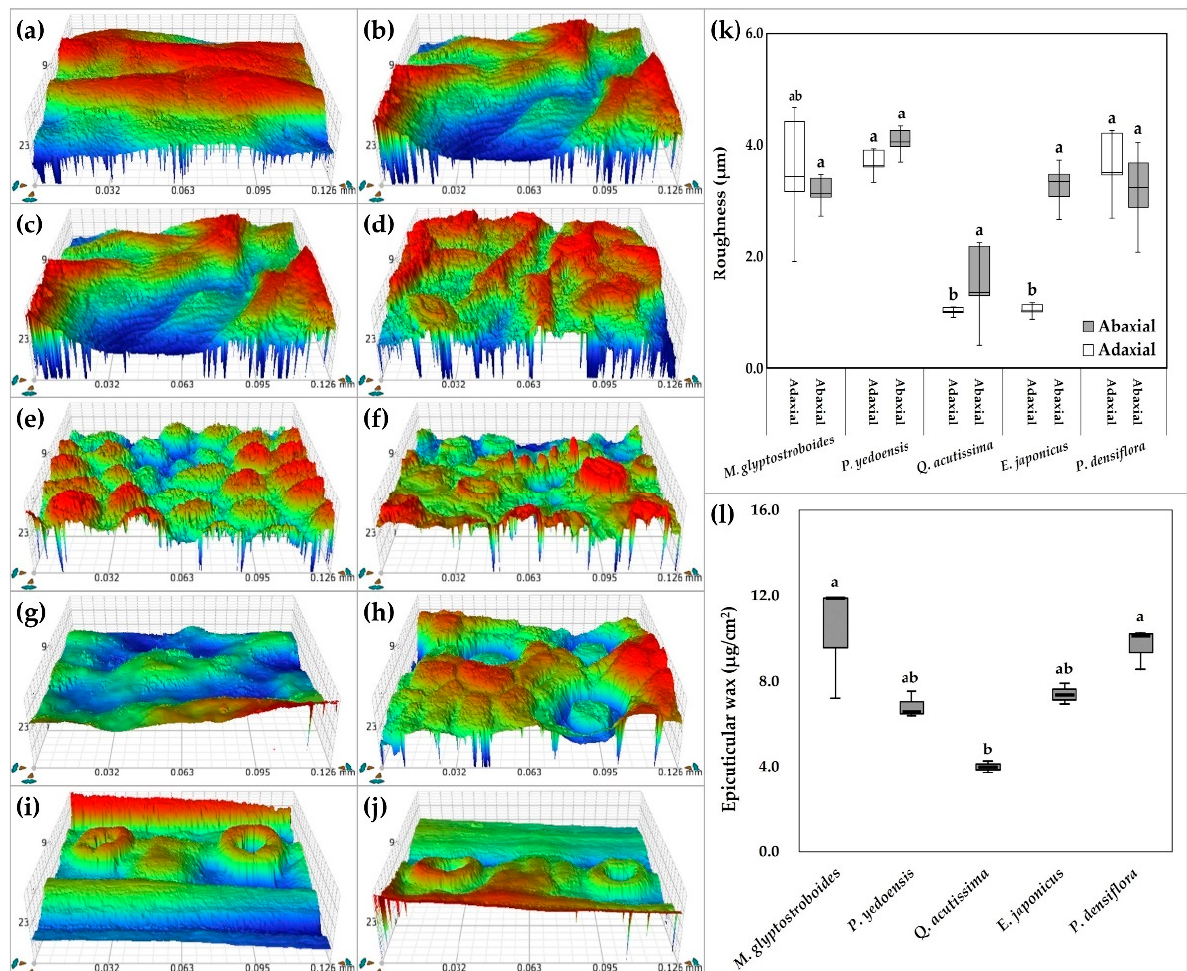
Figure 5. 3D surface topography variations of leaf surfaces among different species, which are distinguished by roughness and epicuticular wax: ( a – j ) 3D surface topography reconstructions showing surface roughness using non-contact surface profiler on ( a , c , e , g , i ) adaxial and ( b , d , f , h , j ) abaxial leaf surfaces (magnification: × 50), ( k ) leaf roughness across adaxial and abaxial leaf surfaces, and ( l ) cuticular wax quantification. Box plots depict the median value (centerline) and the first and third quartiles (box edges). Lowercase letters on top of box plots indicate significantly different groups as determined via the non-parametric Kruskal–Wallis test ( p < 0.05) among species. Note: ( a , b ) M. glyptostroboides , ( c , d ) P. yedoensis , ( e , f ) Q. acutissima , ( g , h ) E. japonicus , and ( i , j ) Pinus densiflora .